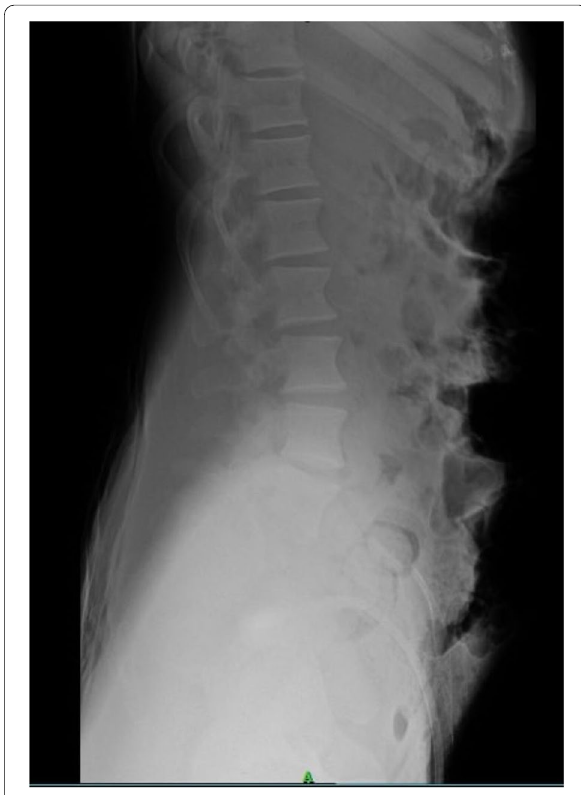
Fig. 6 Normal lumbar spine